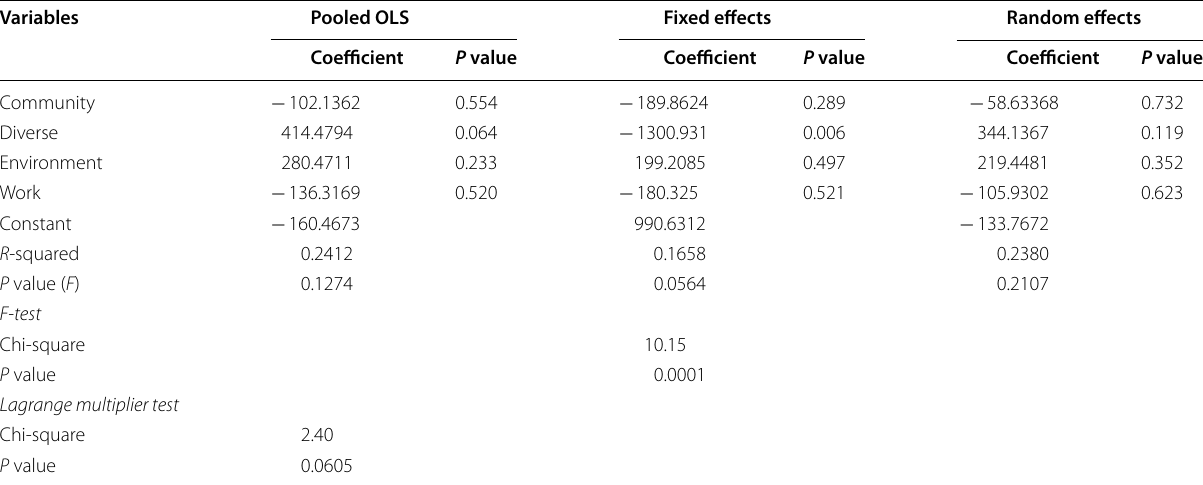
The result is evaluated based on 95% level of significance